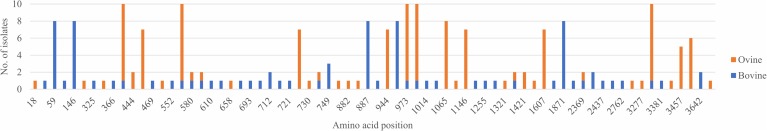
Location of all amino acid substitutions identified in bovine and ovine isolates. For each amino acid residue, the number of isolates that had a substitution at that position is given. Positions are numbered relative to the polyprotein of BVDV-1b AU526 (MG950344).